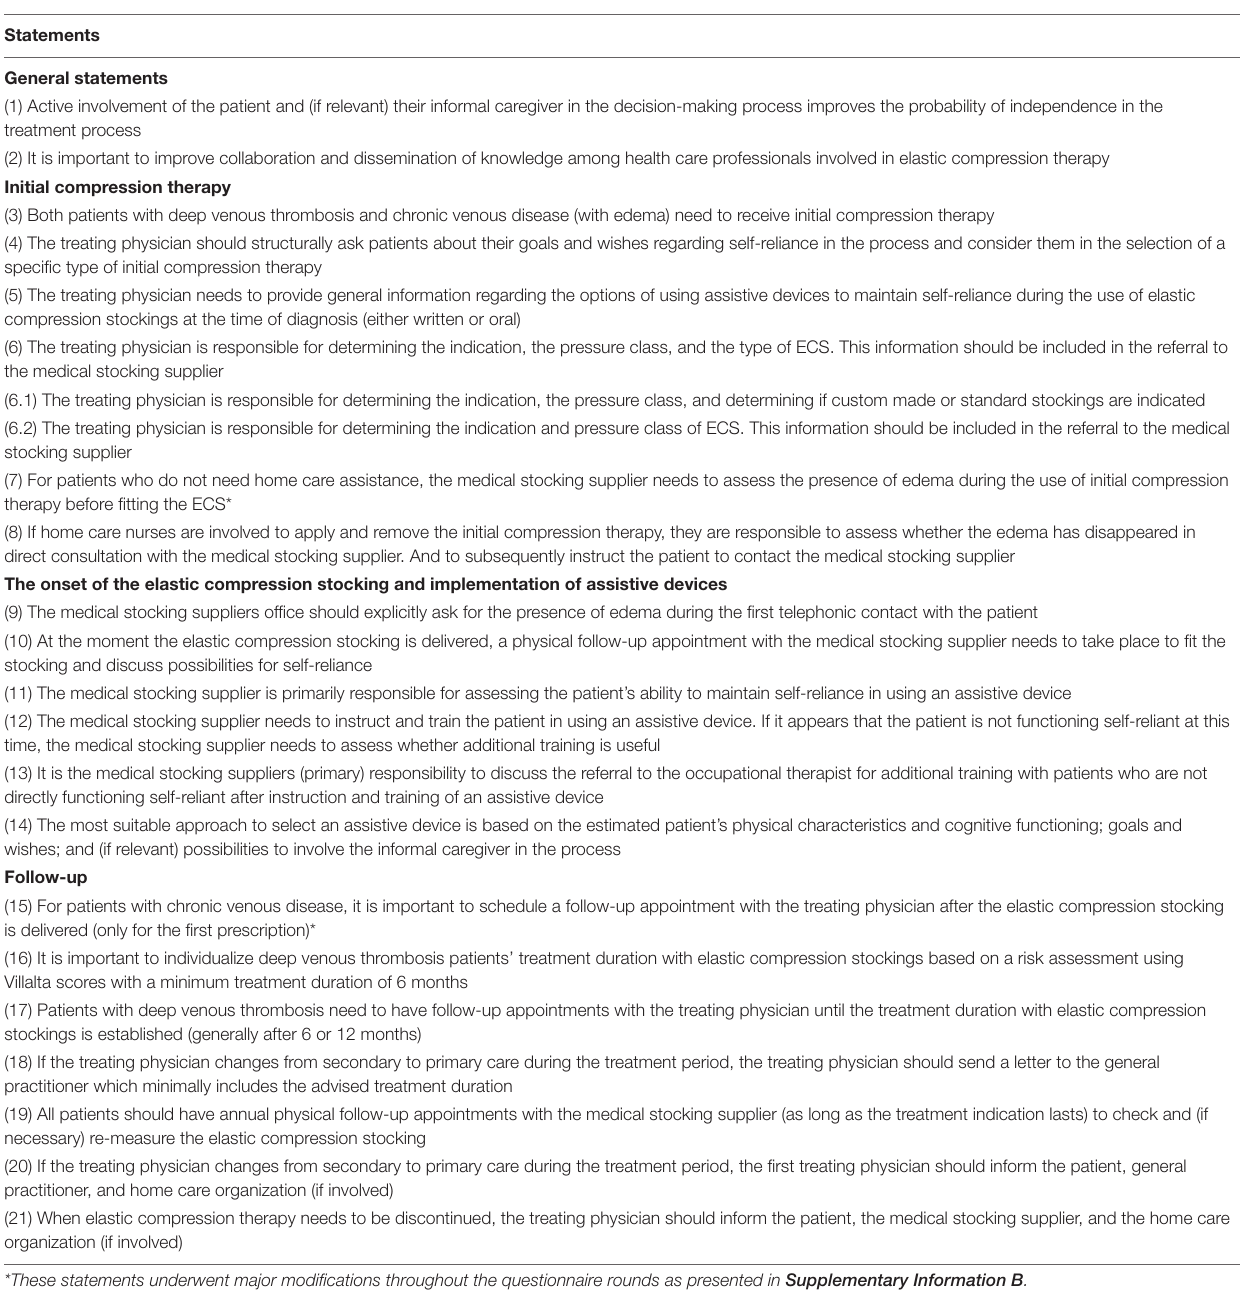
TABLE 2 | Final statements and consensus levels per questionnaire